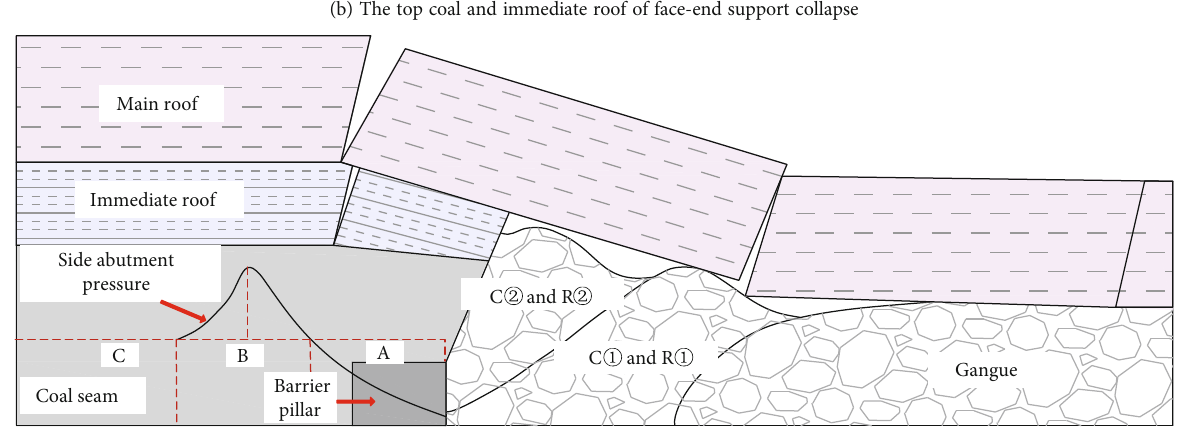
Figure 2: Collapse process of coal and rock mass and evolution of side abutment pressure in face-end